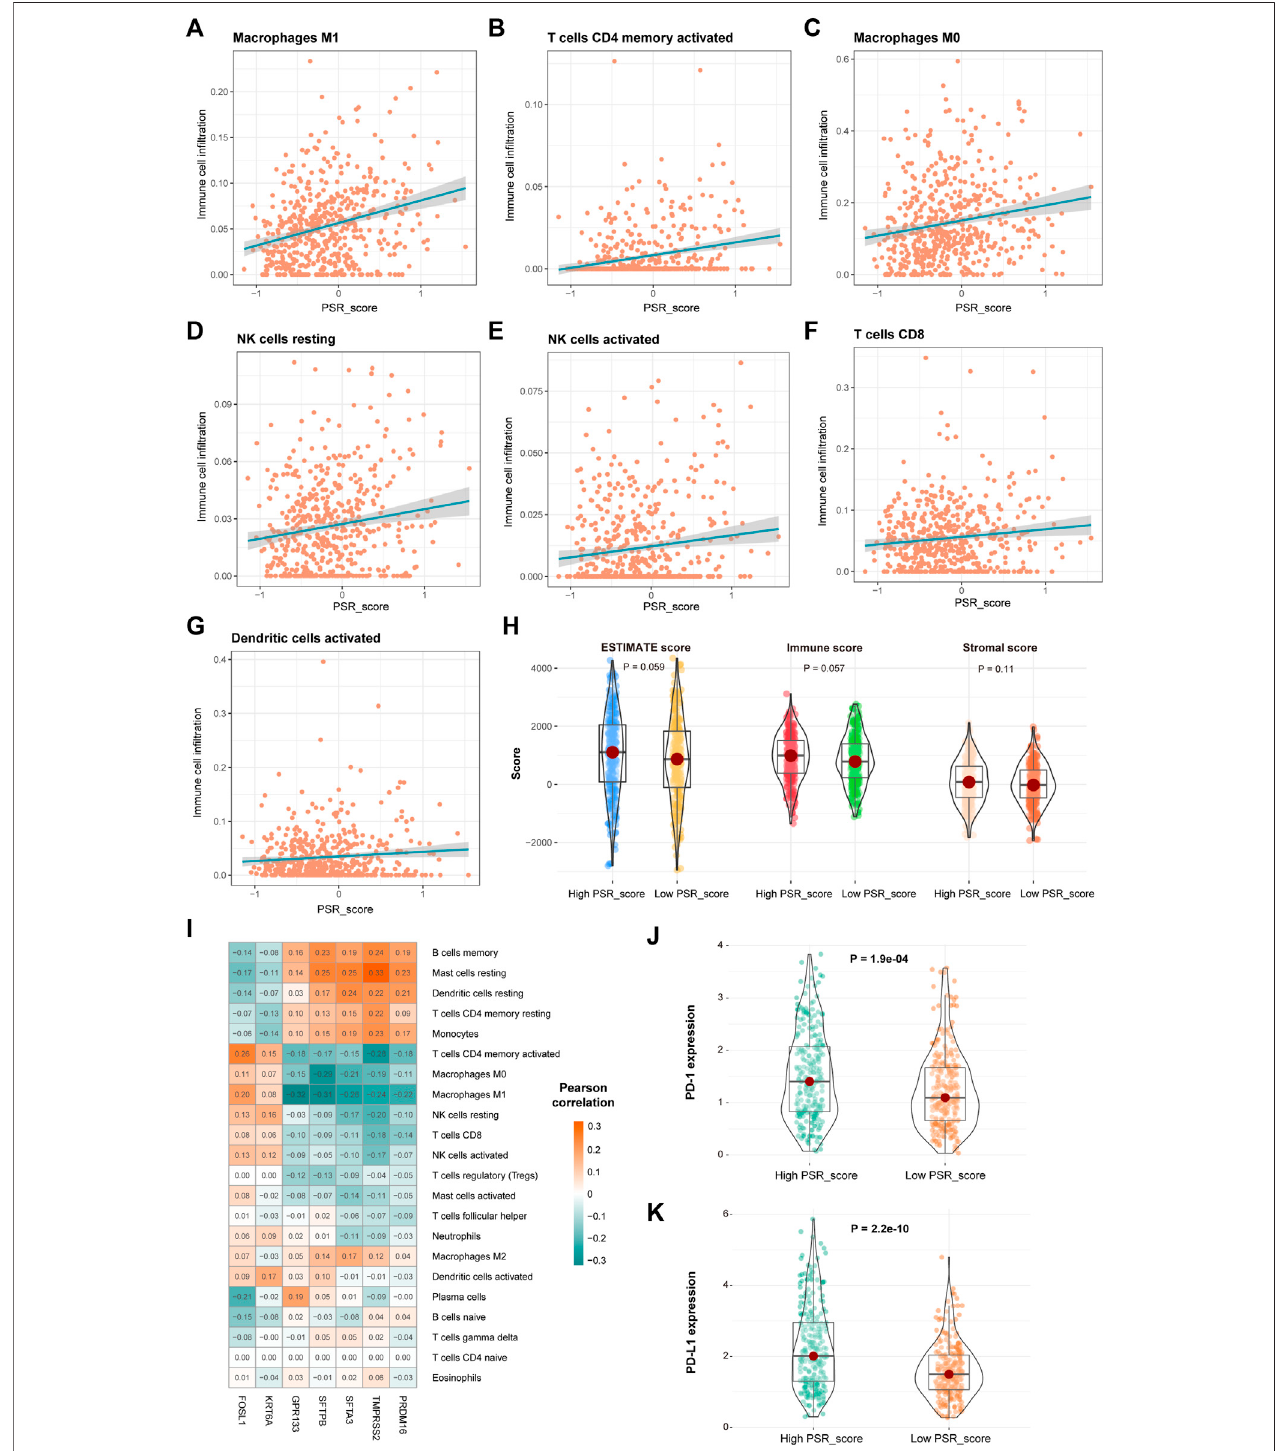
FIGURE 6 | Correlation of PSR_score and immune cell in fi ltration. (A – G) Positive correlation between PRG_score and immune cells. (H) Distribution of the ESTIMATE score in high and low PRG_score groups. (I) Correlations between the abundance of immune cells and seven genes in the proposed model. (J – K) Expression of PD-1 and PD-L1 in high and low PRG_score groups.